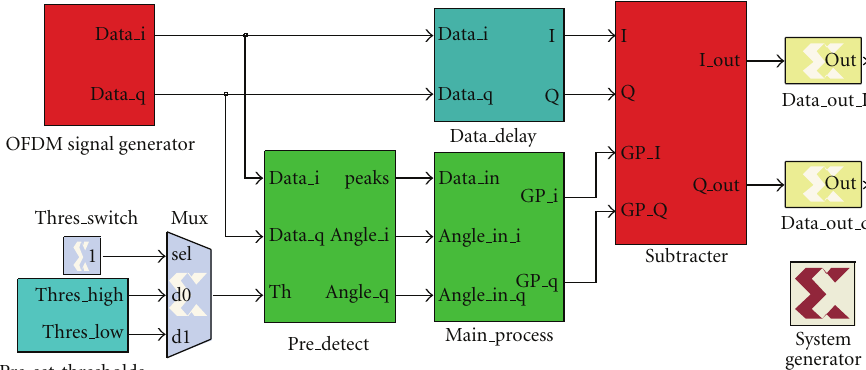
Figure 11: The top module of FPGA